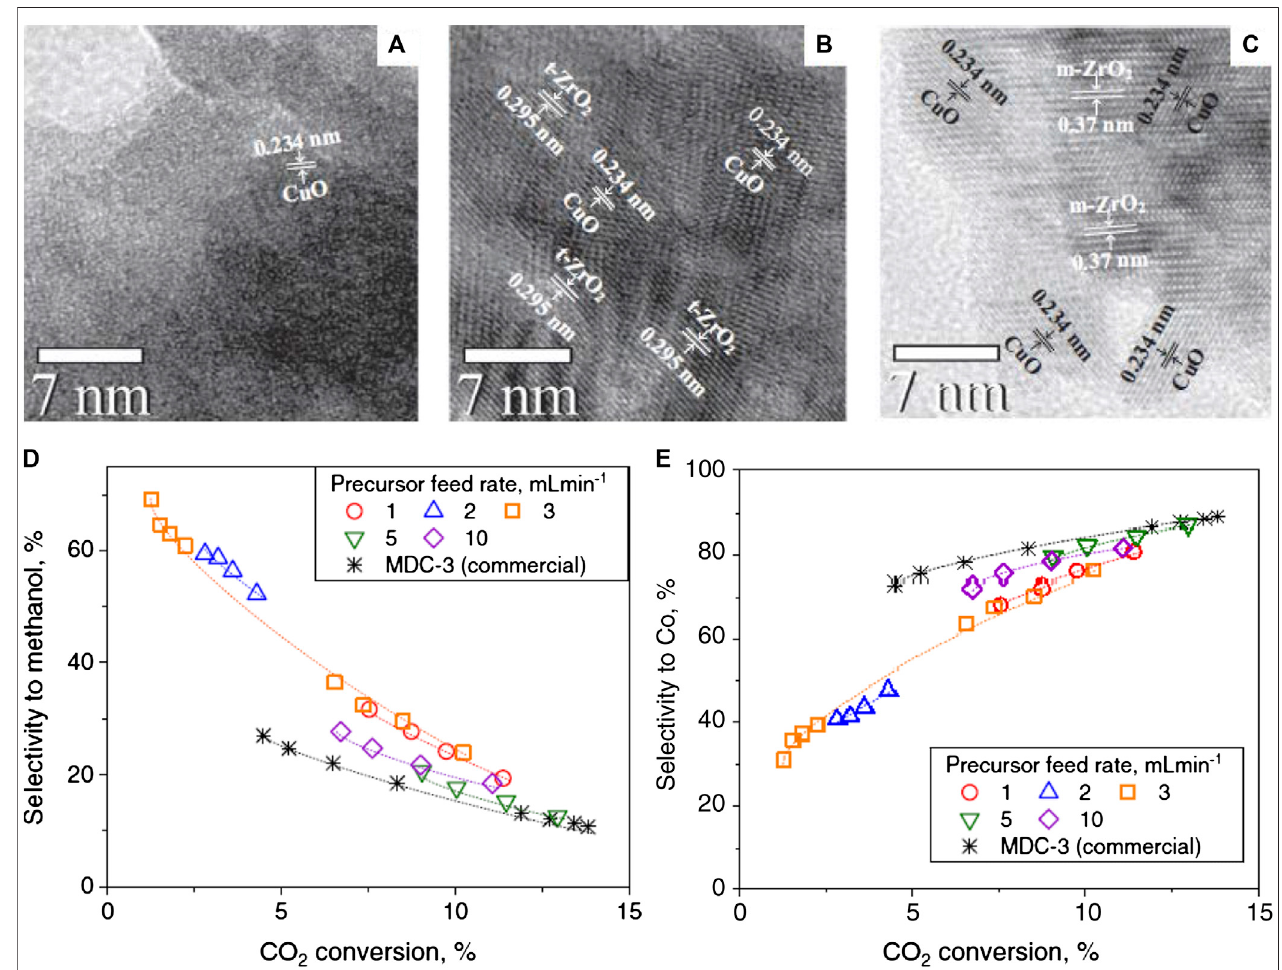
FIGURE11 | TEM of (A) Cu/a-ZrO 2 , (B) Cu/t-ZrO 2 and (C) Cu/m-ZrO 2 catalysts (Witoonet al.,2016). (D) The selectivity tomethanol asafunction CO 2 conversion overFSP-madeCuO/ZrO 2 andcommercialCuO/ZnO/Al 2 O 3 atdifferentcontacttimes. (E) TheselectivitytoCOasafunctionCO 2 conversionoverFSP-madeCuO/ZrO 2 and commercial CuO/ZnO/Al 2 O 3 at different contact times. The contact time of commercial CuO/ZnO/Al 2 O 3 and CuO/ZrO 2 prepared at P (cid:2) 1 – 10 ml min − 1